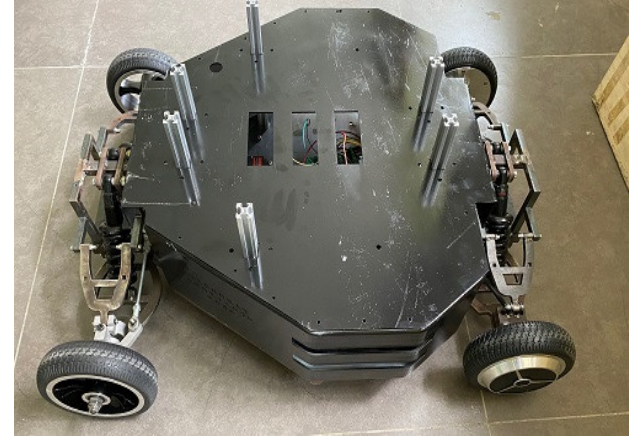
Figure 15. Assembly drawing of the test prototype.